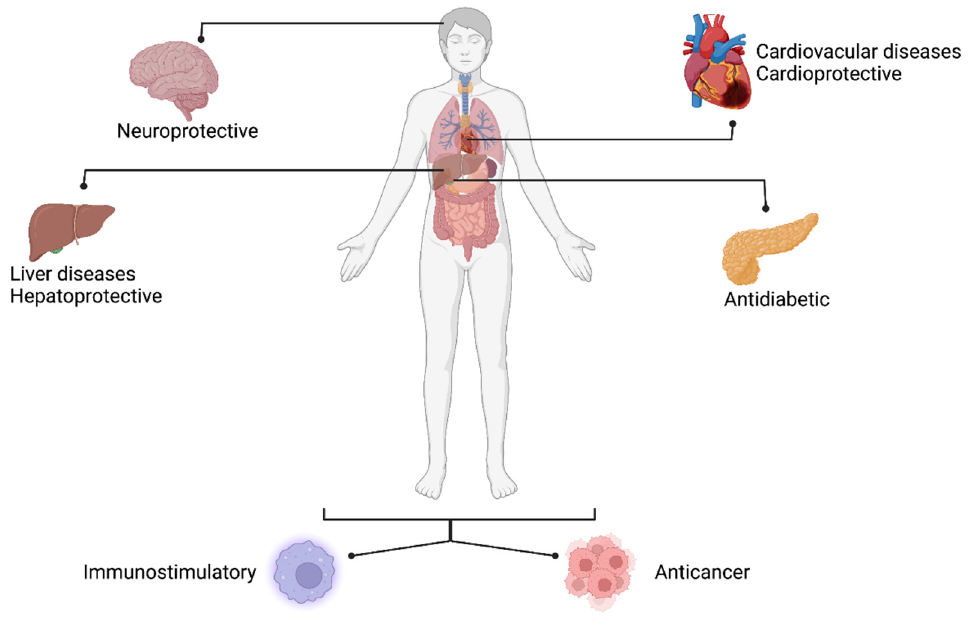
Figure 1. Illustration of the applicability of mulberry in biomedicine (created with BioRender.com, accessed on 10 February 2023) .